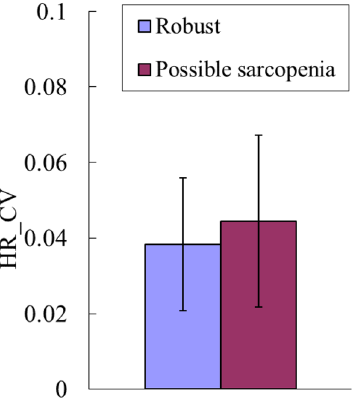
Figure 9. HR_CV did not differ significantly between robust and possible sarcopenia.